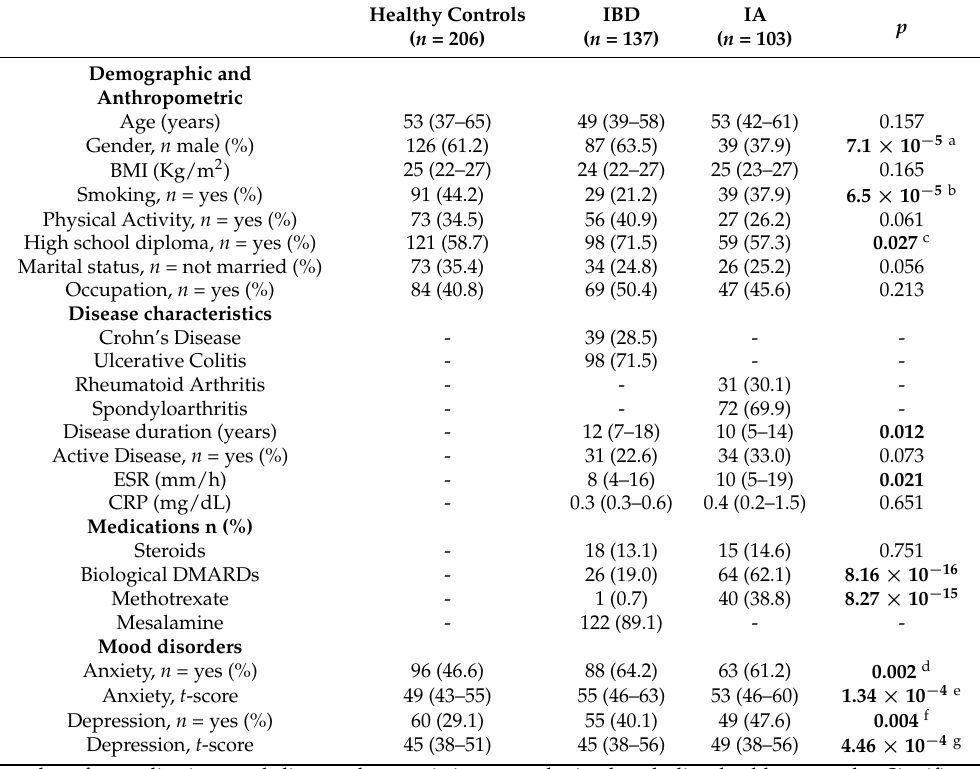
Table 1. Characteristics of the study